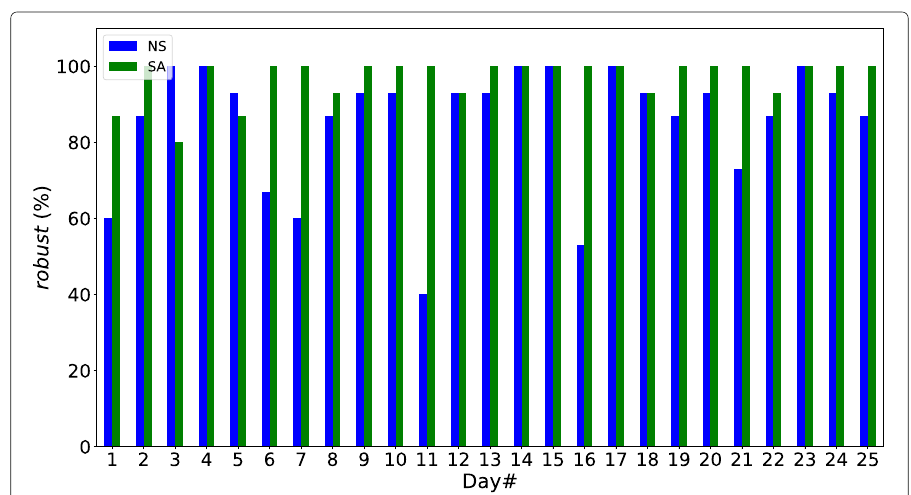
Fig. 11 Summers. For 20% prediction error in occupancy, SA is more reliable and robust NS across all the 25 days of summer